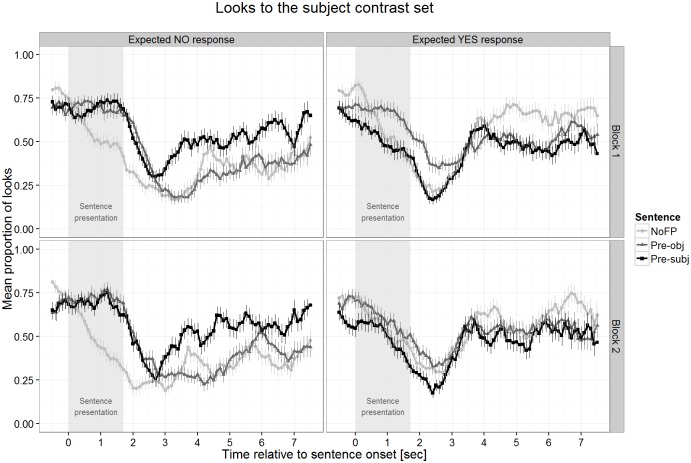
Looks to the subject alternative set plotted separately for block and expected response.